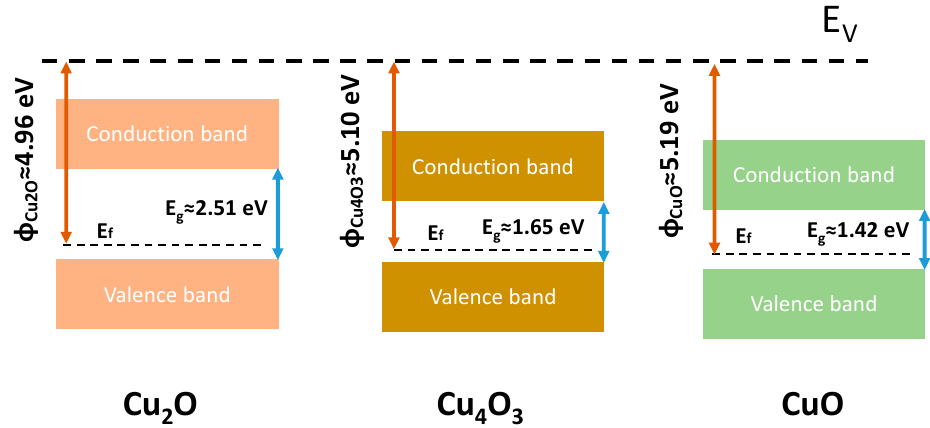
Figure 8. The band diagrams of Cu 2 O, Cu 4 O 3 , and CuO thin films.